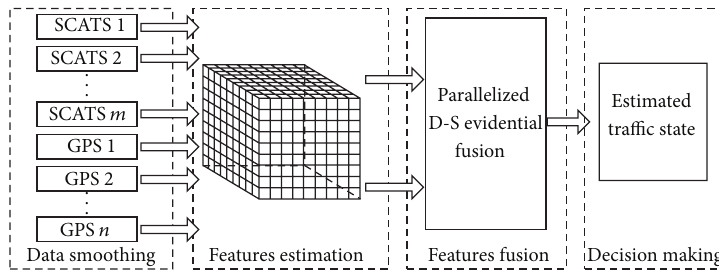
Figure 5: Flowchart of traffic state estimation consists of data smoothing, features estimation, features fusion, and decision